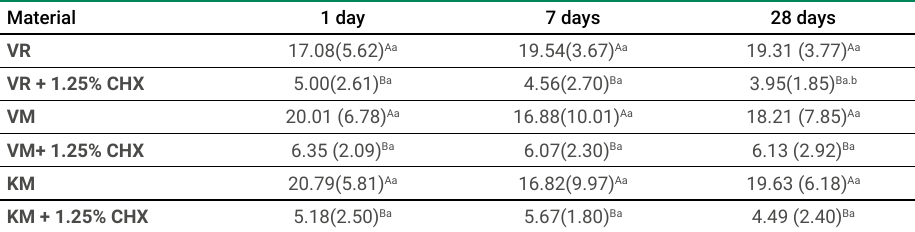
Table 2. Comparison of means (SD - standard deviations) in MPa of flexural strength for the glass ionomer cements containing or not 1.25% CHX at different storage times.